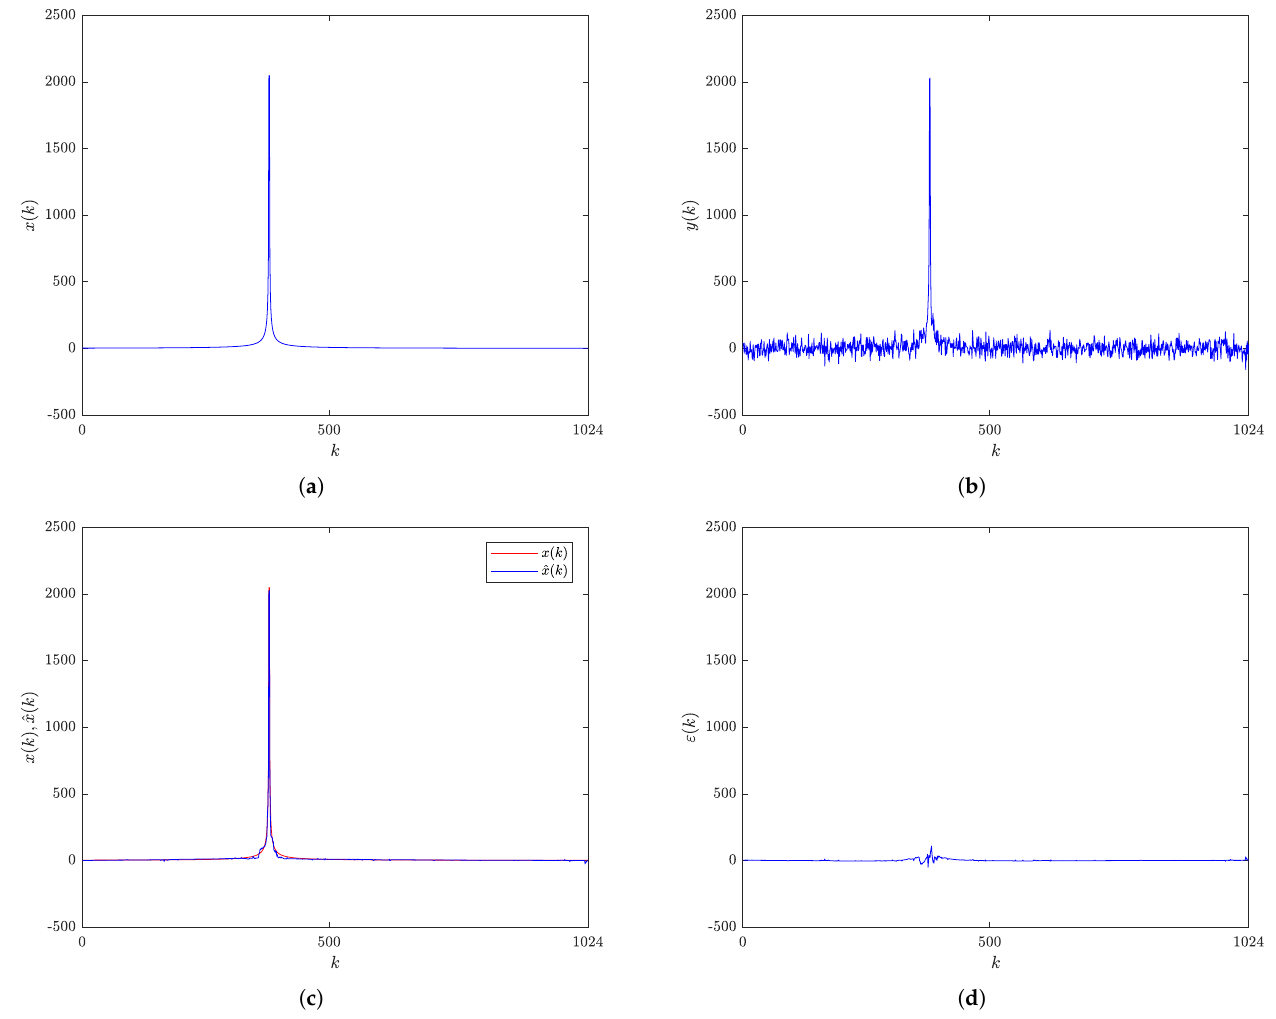
Figure 6. Sing signal: ( a ) Original signal. ( b ) Noisy signal (SNR = 7 dB). ( c ) Original and RBF-RICI filtered signal ( Γ = 0.99, R c = 0.01). ( d ) Filtering